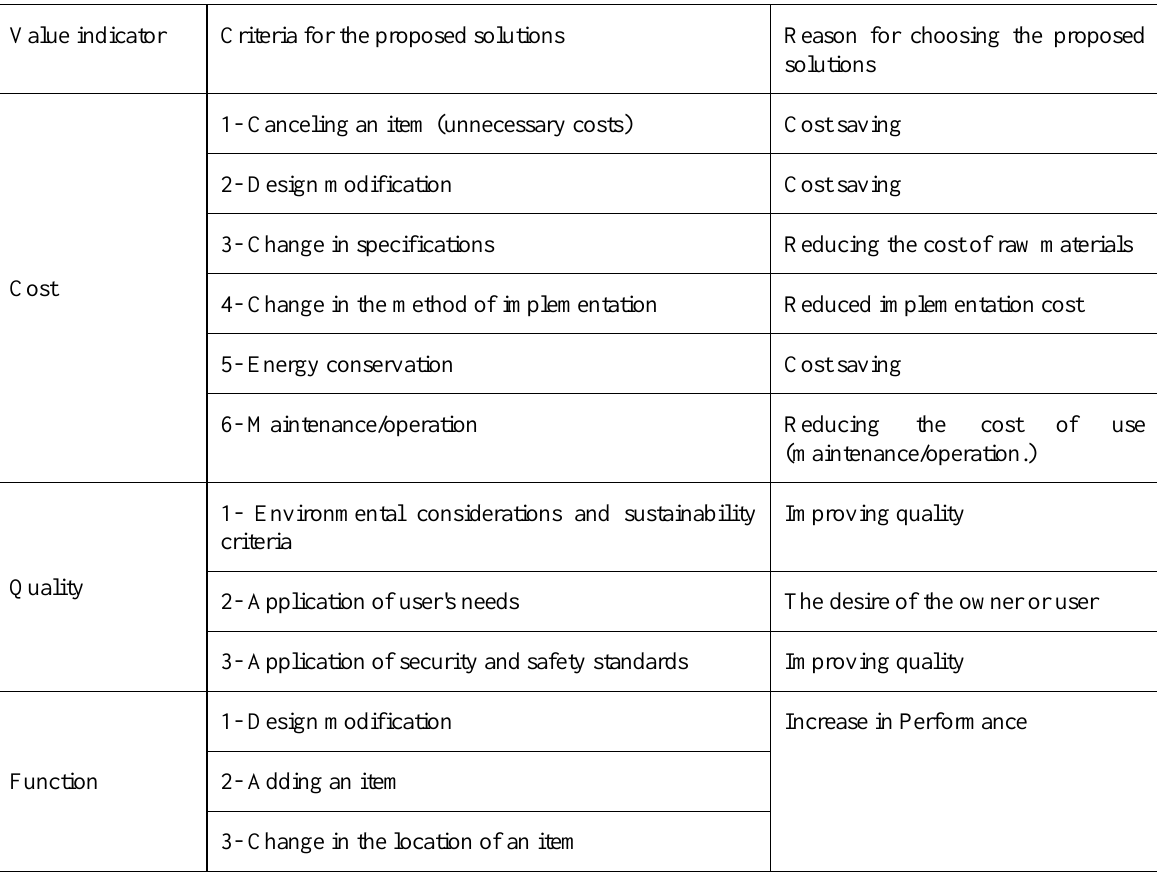
Table 5. Checklist of value indicators and suggested design solutions. Source: